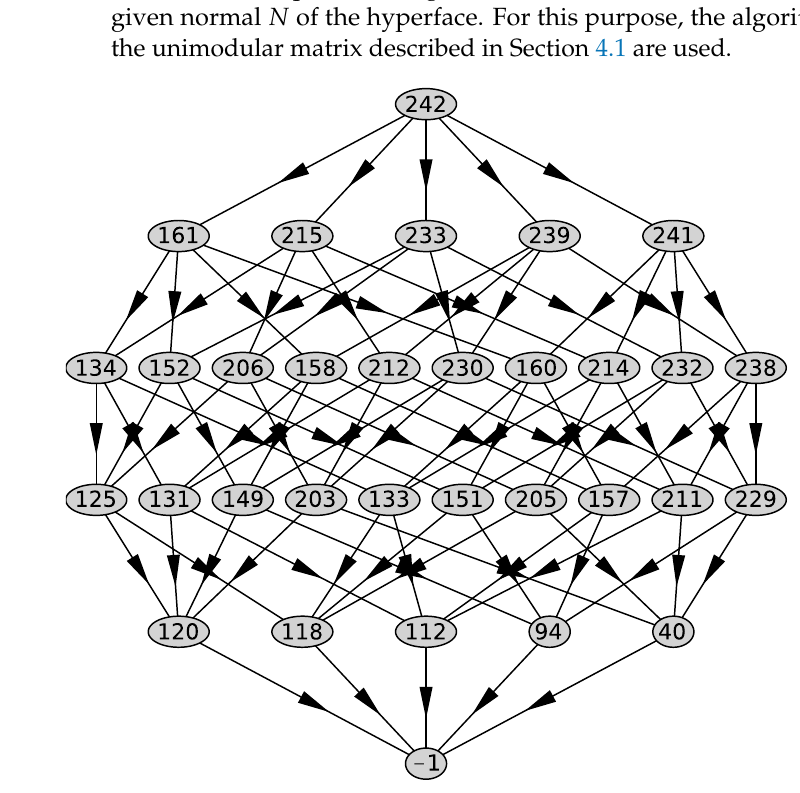
Figure 5. Graph of the polyhedron Γ ( E 1 S ) of Equation (48).